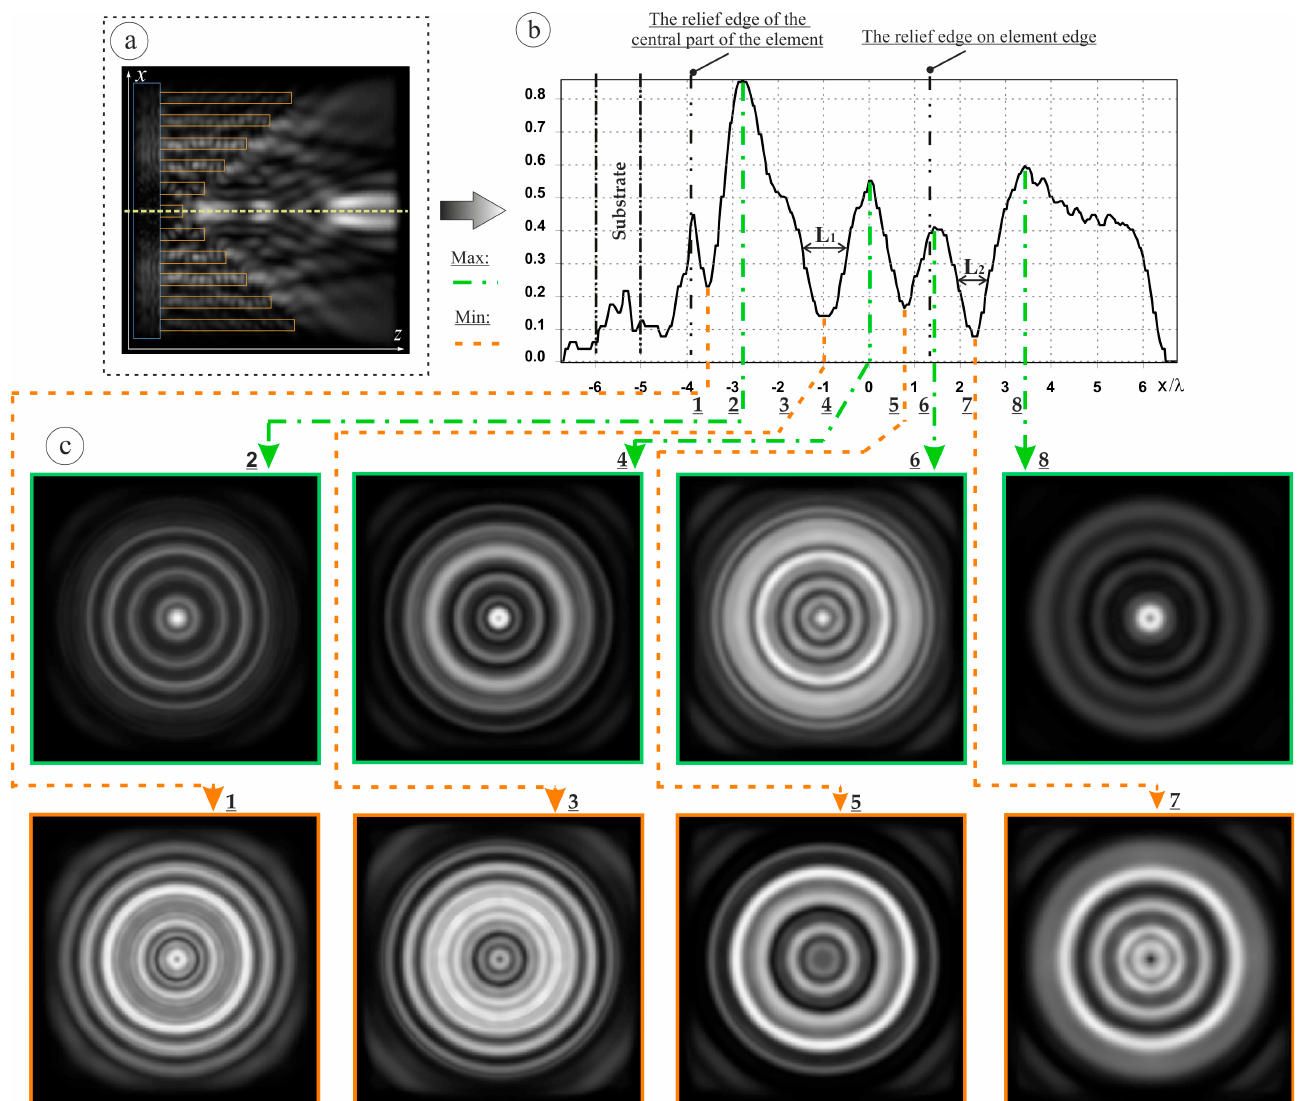
Figure 11. Two-dimensional diffraction pattern of the Laguerre–Gaussian mode (1,0) (see Figure 9d): ( a ) xz plane, ( b ) cross section in the xz plane, and ( c ) cross sections in the xy plane.